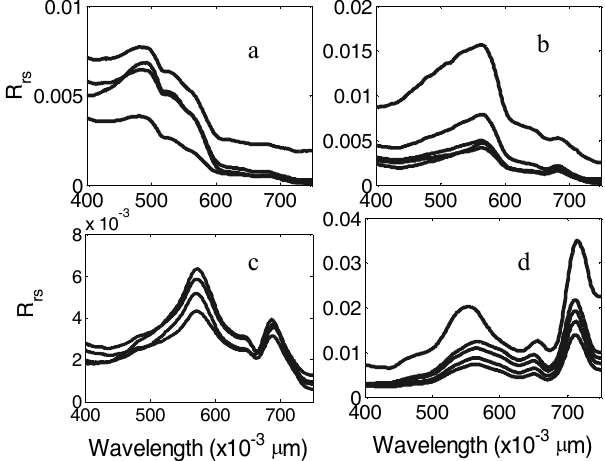
Figure 5. The typical remote-sensing reflectance spectra R rs (λ) measured at four stations in the study area during 2012 and 2013. (a) Relatively clear waters off Chennai, (b) moderately turbid wa- ters off Point Calimere, (c) phytoplankton-dominated harbour wa- ters of Chennai and (d) eutrophic